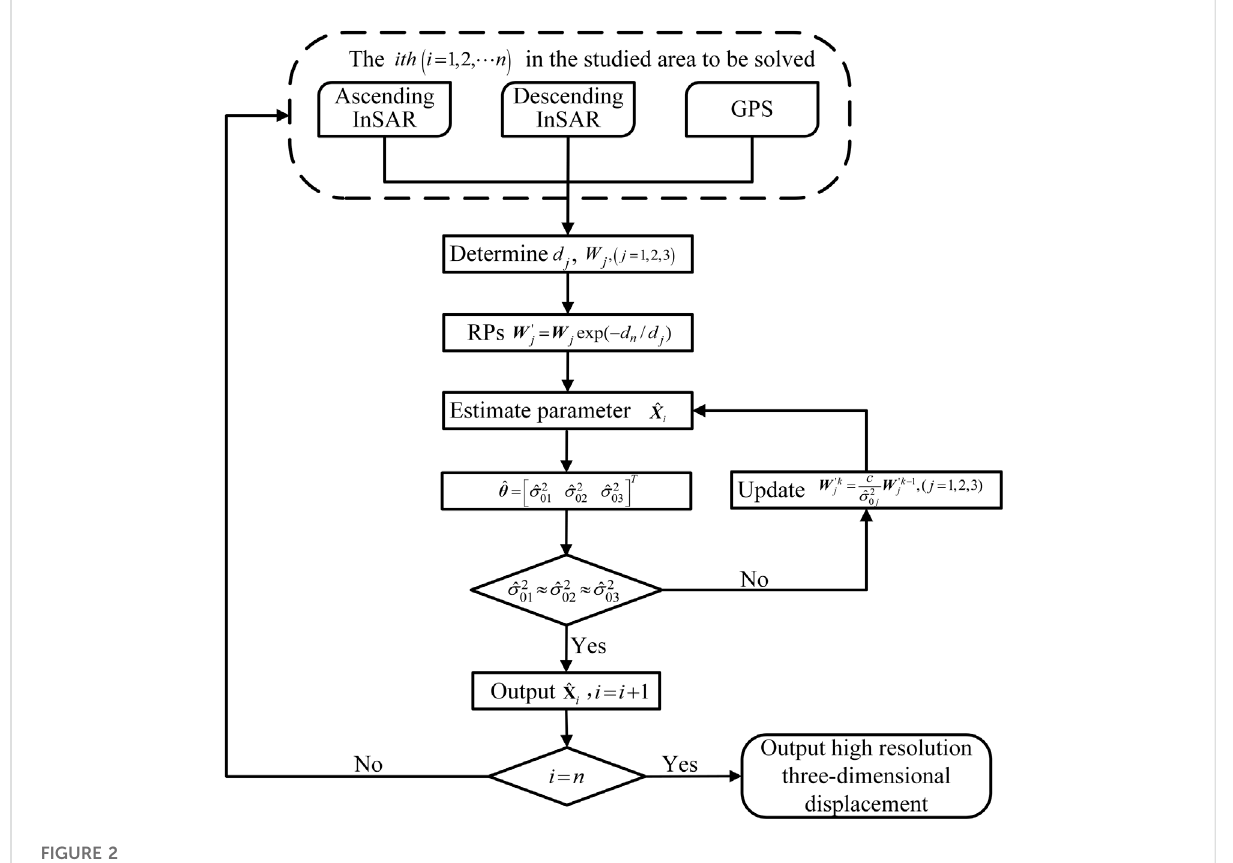
The fl owchart of the ESISTEM-VCE